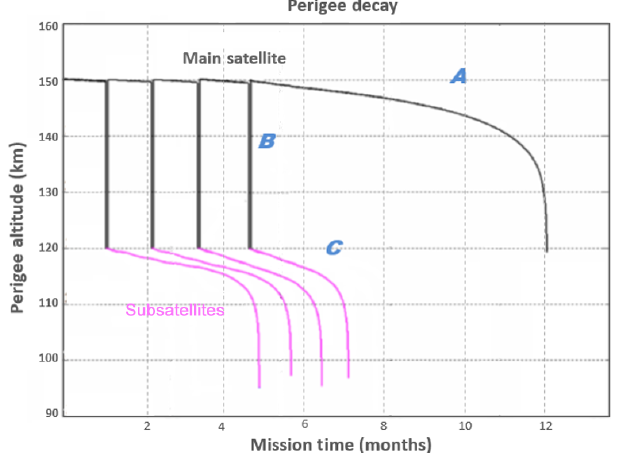
Figure 8. Schematic of the main phases of the perigee history for the Daedalus main satellite (gray lines) and four subsatellites (ma- genta lines). The subsatellites are released during four correspond- ing descents (“deep dips”) of the main satellite down to